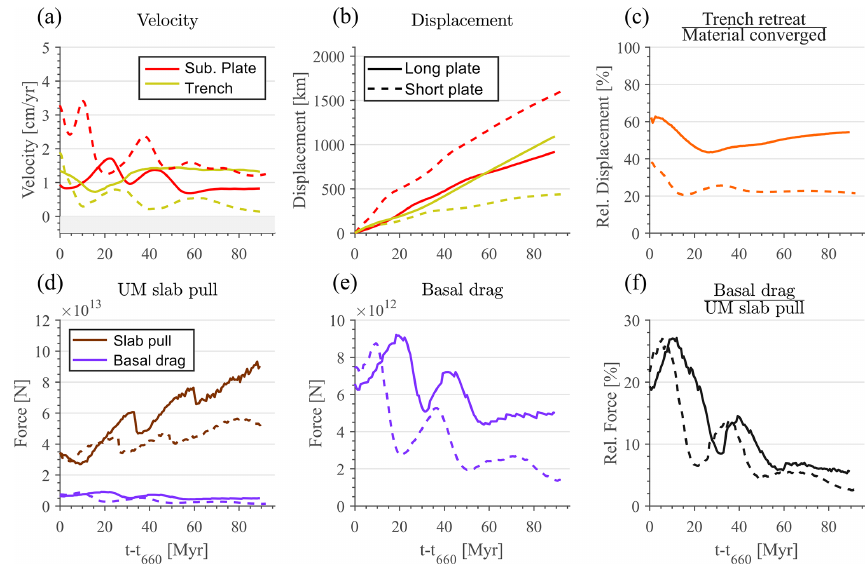
Figure 4. Temporal evolution of the long-plate reference model (full lines) and the short-plate reference model (dashed lines). t - t 660 indicates the time since the initial interaction of the slab with the ULMB. (a) Velocity of the subducting plate (positive towards the upper plate, red) and the trench (positive away from the upper plate, yellow), measured at 2000km distance from the initial subducting plate ridge. (b) Displacement of the subducting plate (red) and the trench (yellow) relative to the initial condition. (c) Percent of plate convergence (calculated as the sum of trench retreat and plate displacement) achieved by trench retreat. (d) Upper-mantle slab pull and basal drag below the subducting plate, calculated as described in the main text. (e) Basal drag force from (d) . (f) Ratio of basal drag to upper-mantle slab pull force. This shows that basal drag is of a similar magnitude as effective slab pull (i.e. the difference between gravitational pull and the viscous mantle resistance on the slab sides), which is ∼ 10% of the upper-mantle slab pull